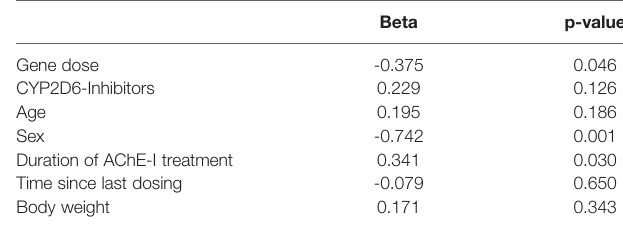
TABLE 4 | Prediction of serum concentration of donepezil: Multivariate regression model; n =